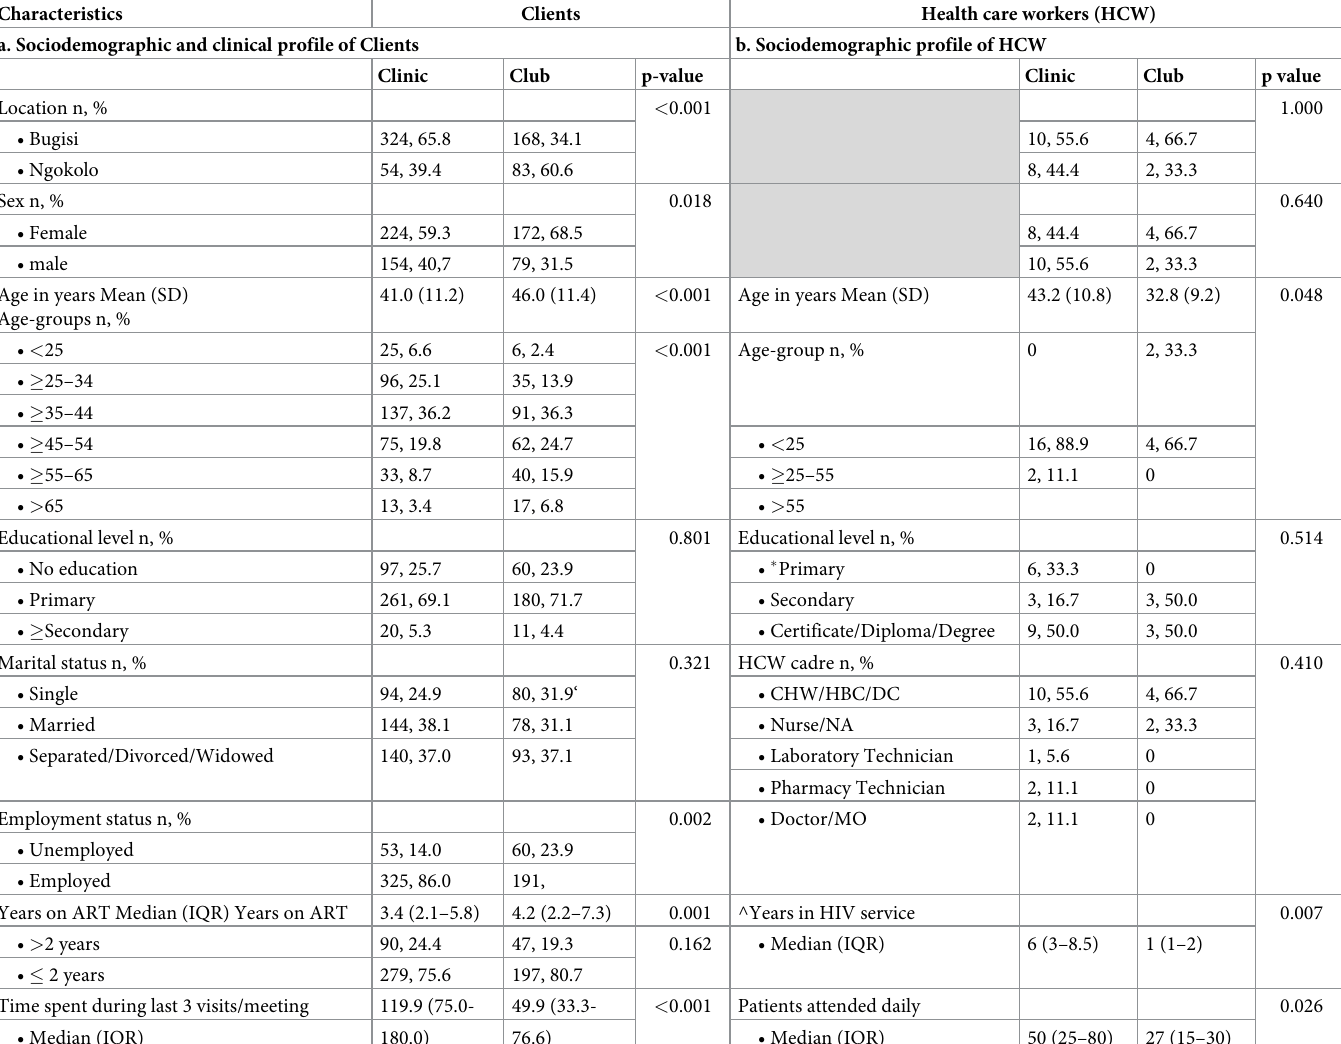
Table 2. Characteristics of study participants (clients and healthcare